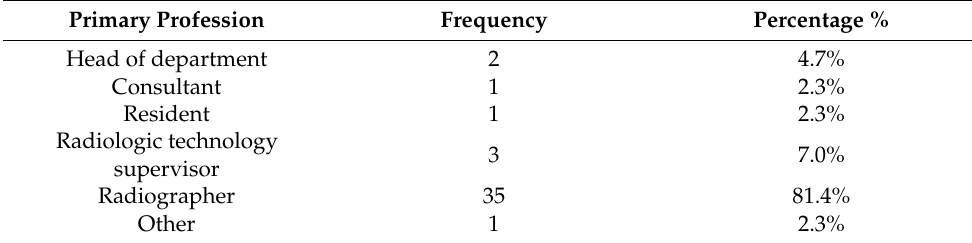
Table 1. Function or role in the department.